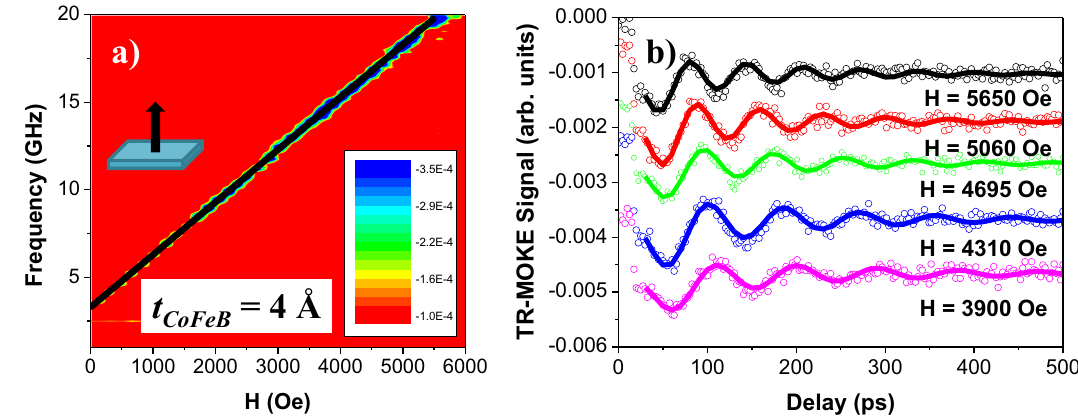
Figure 3. ( a ) VNA-FMR spectra of the [CoFeB (4 )/Pd (10 )] 5 multilayer thin film with the external magnetic field applied perpendicularly to the sample plane. The black line corresponds to the fits using the Å Å Kittel formula (Eq. 4). ( b ) Time-resolved magneto-optical Kerr effect (TR-MOKE) signals of a [CoFeB (2 )/ Pd (10 )] 5 multilayer thin film under different external applied fields (H = 5650, 5060, 4695, 4310 Oe and 3900 Å Oe) and when H was applied at θ H = 78°. Theoretical curves (solid curves) are fits to the experimental data (open Å symbols) using Eq. (5). Data was moved along the vertical axis for